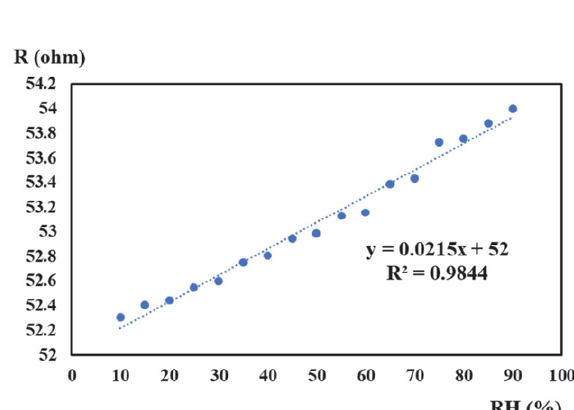
Figure 7. The transfer function of the sensor in humid air (RH = 10%–90%)